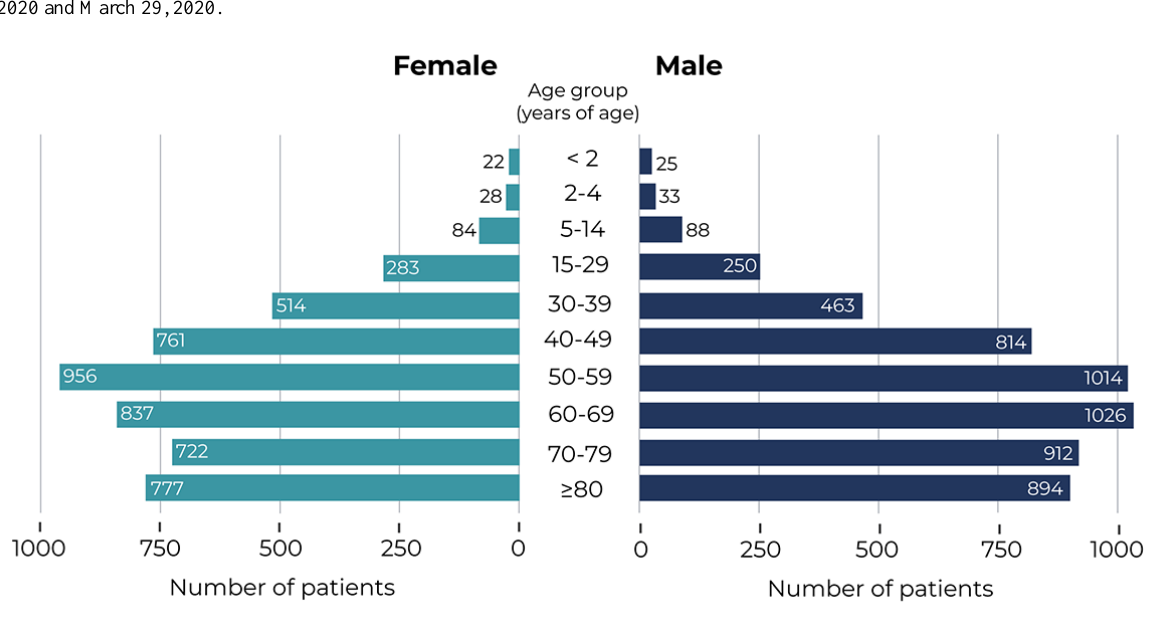
Figure 3. Age distribution of incident cases of COVID-19 in females (left) and males (right) in the study population for the period comprised